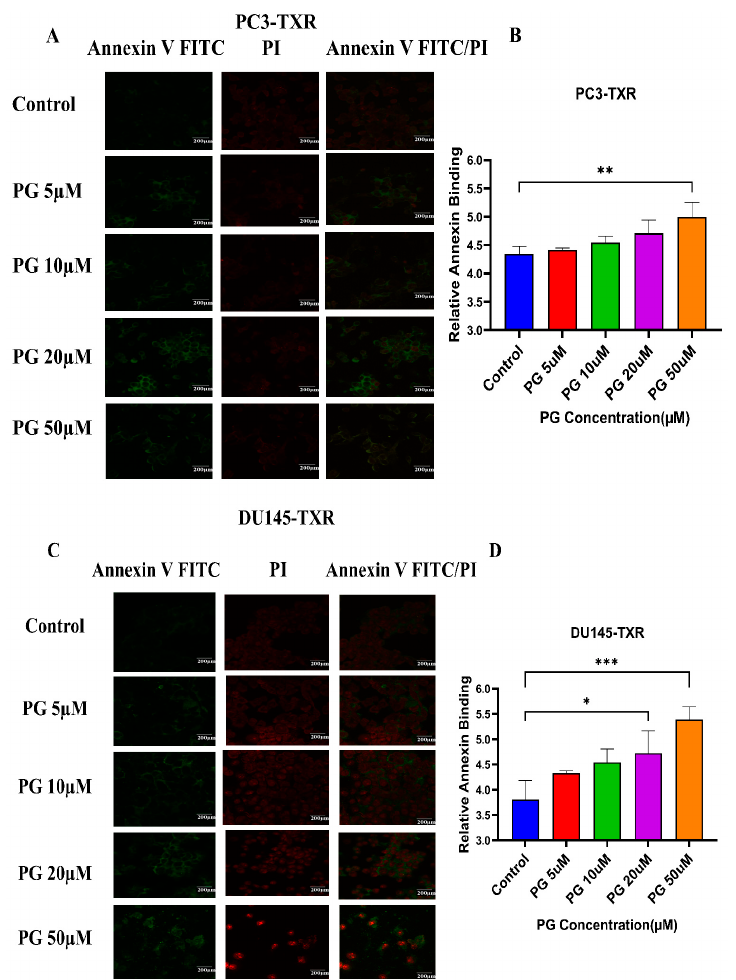
Figure 5. PG treatment elicits apoptosis in taxane-resistant PCa cell lines. ( A ) PC3-TXR and ( C ) DU145- TXR cell lines were treated with varying concentrations of PG for 48 h, and apoptosis was detected by annexin V FITC/PI staining. Images were taken via confocal microscopy and analyzed using ImageJ. In the taxane-resistant PCa cell lines, the relative annexin V FITC binding was higher in the treatment groups compared to that of controls. ( B ) and ( D ) show relative annexin V binding plotted against concentrations of PG for PC3-TXR and DU145-TXR, respectively. Images were taken at 60 × magnification. Data are depicted as mean ± SD ( n = 3) and represent three experiments performed in triplicate. * p < 0.05, ** p < 0.01, *** p <